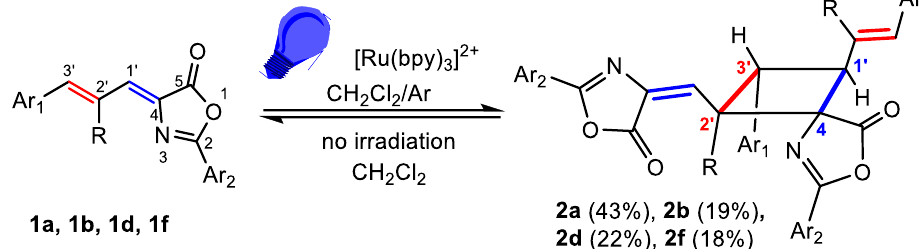
Figure 5. Selective formation of styryl-cyclobutanes 2 from allylidene-5(4 H )-oxazolones 1.